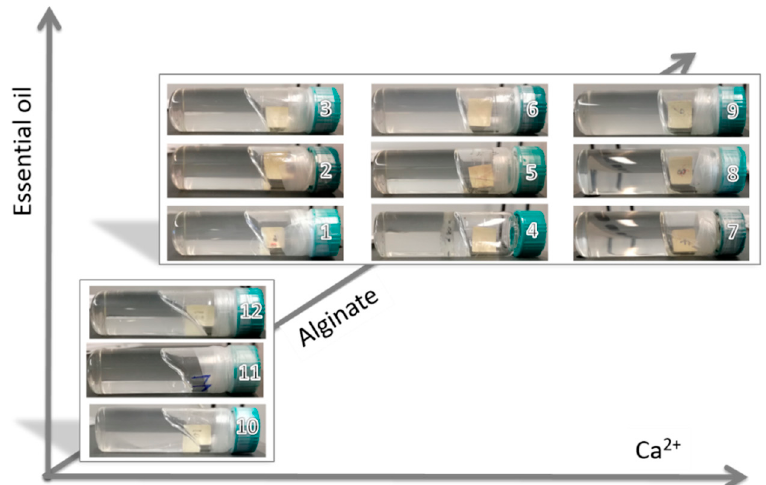
Figure 1. Photographs of alginate-based nanodispersion gels with increasing concentrations of CaCl 2 ( x -axis), essential oil ( y -axis), and alginate ( z -axis). The CaCl 2 concentrations ranges from 4 to 10 mM, the essential oil concentration ranges from 0 to 0.5 wt %, and the alginate concentrations were 0.5 or 1 wt %. Tween 80 was kept constant at 1 wt %.